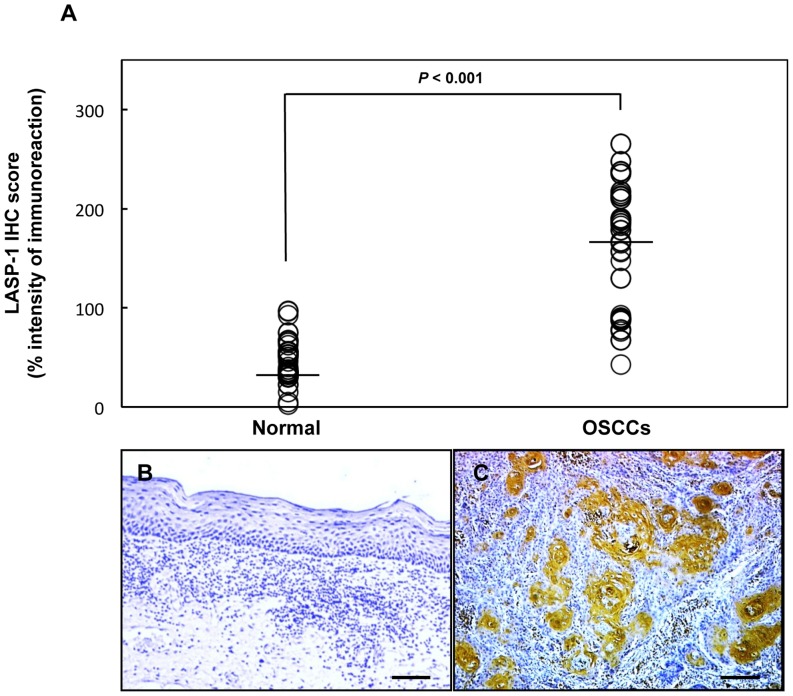
Evaluation of LASP-1 protein expression in primary OSCCs.(A) The status of LASP-1 protein expression in primary OSCCs (n = 50) and the normal counterparts based on an IHC scoring system. IHC scores are calculated as follows: IHC score = 1×(number of weakly stained cells in the field)+2×(number of moderately stained cells in the field)+3×(number of intensely stained cells in the field). The LASP-1 IHC scores for normal oral tissues and OSCCs range from 2.5 to 97 (median, 35) and 43 to 265 (median, 178), respectively. LASP-1 protein expression levels in OSCCs are significantly higher than in normal oral tissues (*P<0.001; Mann-Whitney U test). (B, C) Representative IHC results of LASP-1 in normal oral tissues and primary OSCCs. Original magnification, ×100. Scale bars, 5 µm. LASP-1 is highly overexpressed in OSCCs compared to normal oral tissues.